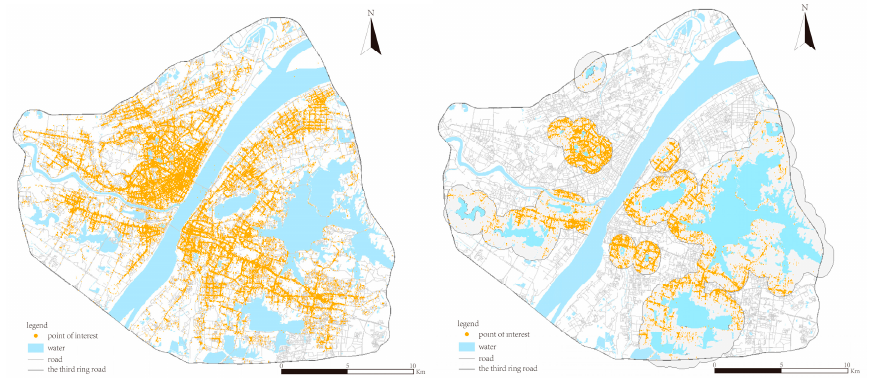
Figure 4. Visualization results of point of interest (POI) data in the Third Ring Road and buffer.